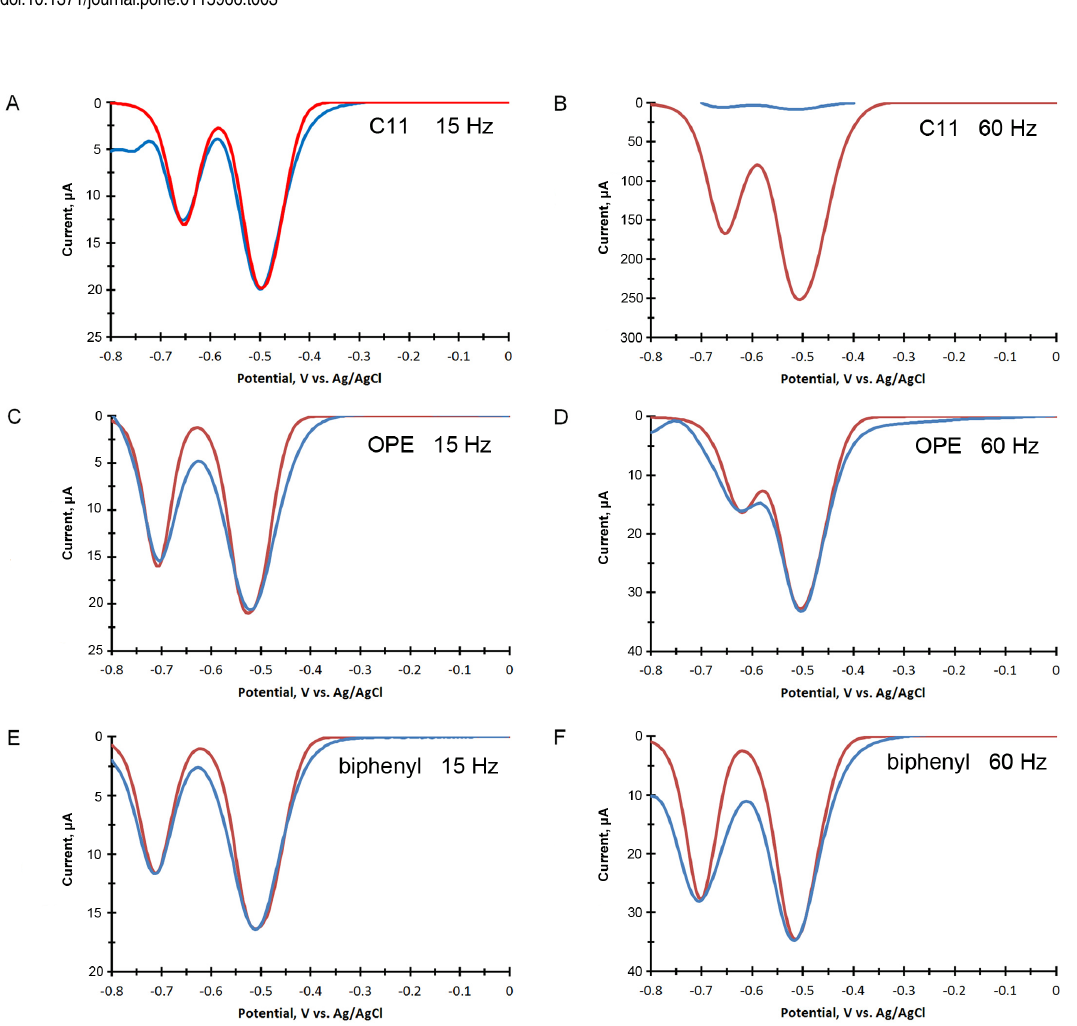
Fig. 4. Background subtracted square wave voltammograms of TNT at modified gold electrodes with experimental data (blue trace) compared to simulations (red trace). Fig. 4A and 4B show the response at a C11 SAM at 15 Hz (A) and 60 Hz (B). For 4B the simulation at 60 Hz could not fit the experimental data, and the parameters for the 15 Hz simulation are repeated for comparison. Figs. 4C and 4D shows the response at the OPE SAM at 15 Hz (A) and 60 Hz (B), Figs. 4E and F shows the response at the biphenyl SAM at 15 Hz (A) and 60 Hz (B). Experimental conditions are listed in Fig. 2. Area of the electrode 5 0.50 cm 2 , [TNT] 5 10 ppm (44 m M). Fitted parameters are listed in Table 2 and simulation settings are listed in the